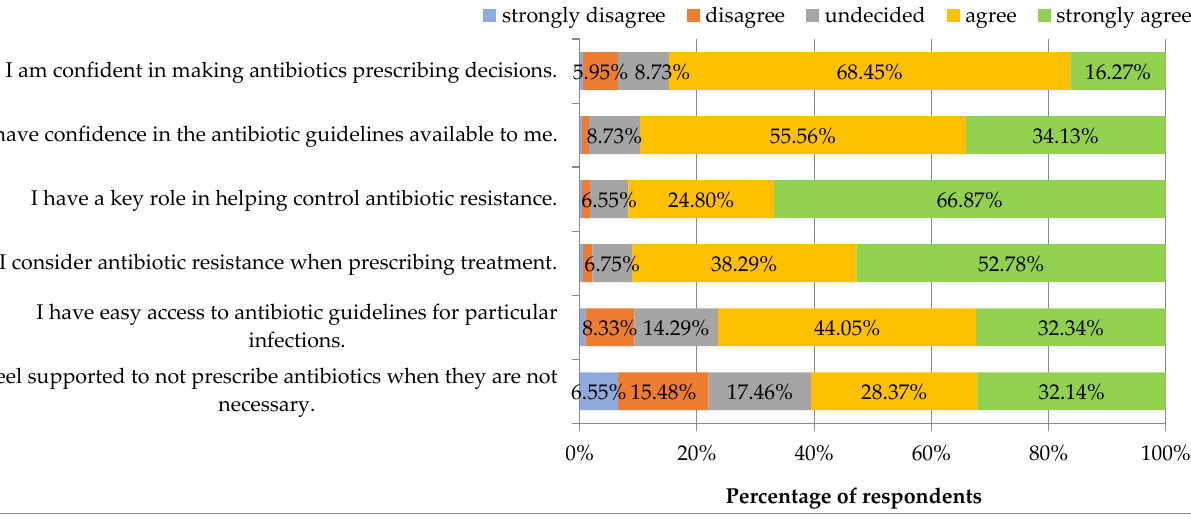
Figure 4. To what extent do you agree or disagree with the following statements? Respondents were more confident in making antibiotic prescribing decisions if they